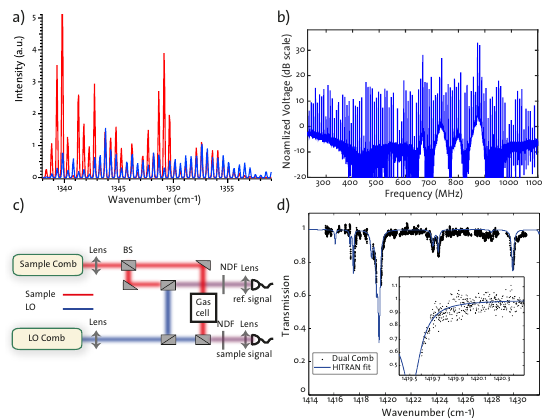
Figure 19: Dual-comb spectroscopy based on QCL combs: a Typical optical spectra of two mid-infrared QCL combs, where the offset fre- quencies f ceo of both combs are identical. b Multi-heterodyne beat of two QCL combs with slightly different comb repetition frequen- cies measured on a fast detector. The multi-heterodyne beat signal contains information on the sample absorption. c Schematic view of the dual-comb spectroscopy setup based on QCL frequency combs. One comb is used as a local oscillator (LO) while the other interro- gates the gas cell. BS: 50-50 Antireflection coated beam splitter, NDF: neutral density filter. d Water vapor transmission spectra in = 1.63 kPa, total pressure P tot = 101.3 kPa, T = 20 ∘ C) air ( P H 2 O measured with our dual-comb spectrometer (800MHz of spectral resolution after averaging) and HITRAN simulation. Inset: expansion of the measured transmission over ∼ 1cm −1 with the full resolution (80MHz). Results published in